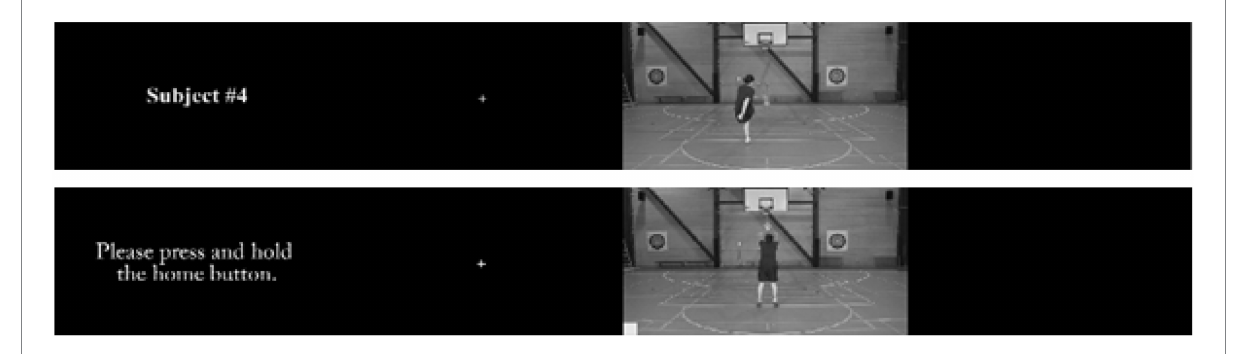
FIGURE 1 Examples of training (top) and testing (bottom) trial